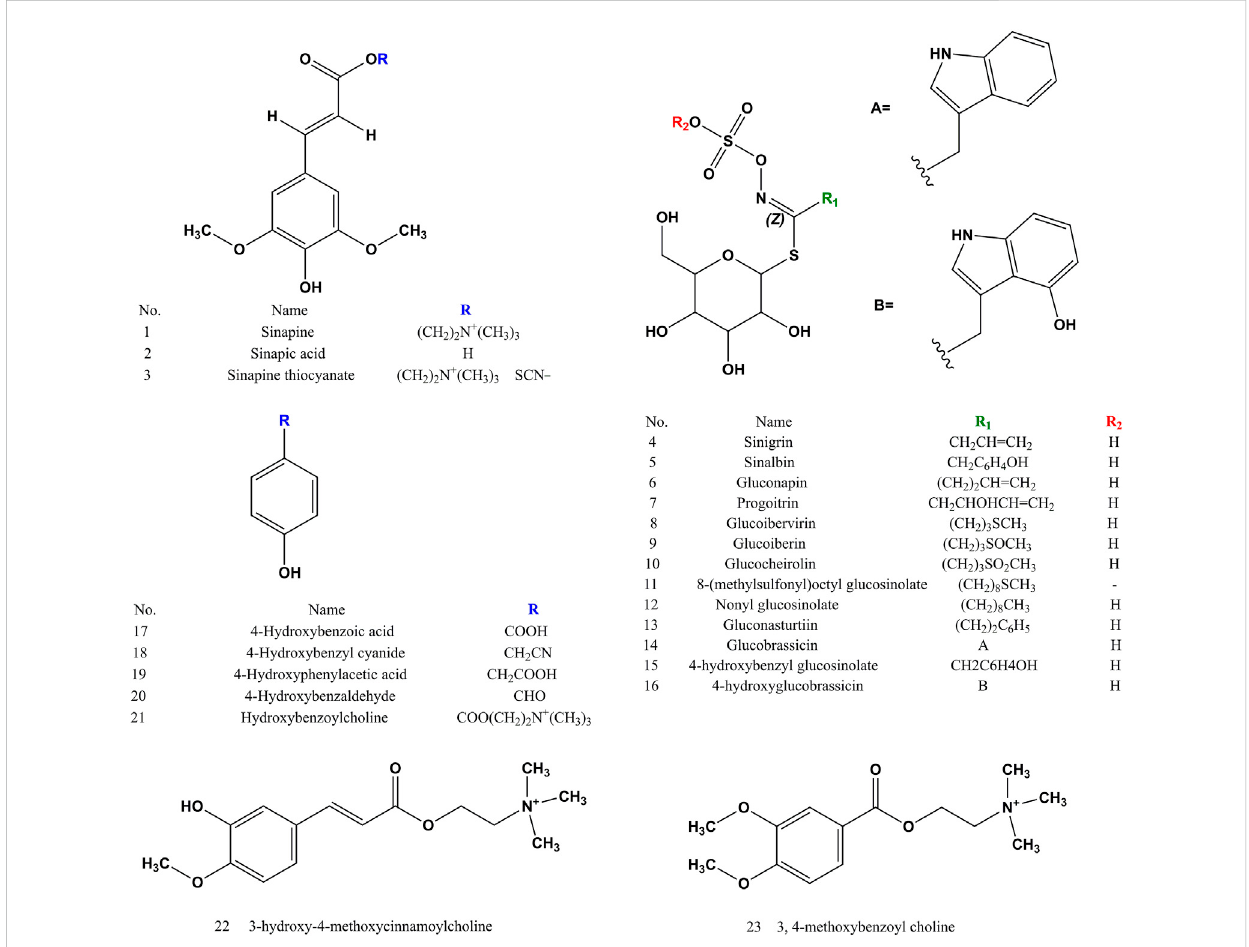
FIGURE 1 Chemical structures of glucosinolates and their hydrolysates identi fi ed from SS (compound 1 – 23 ).